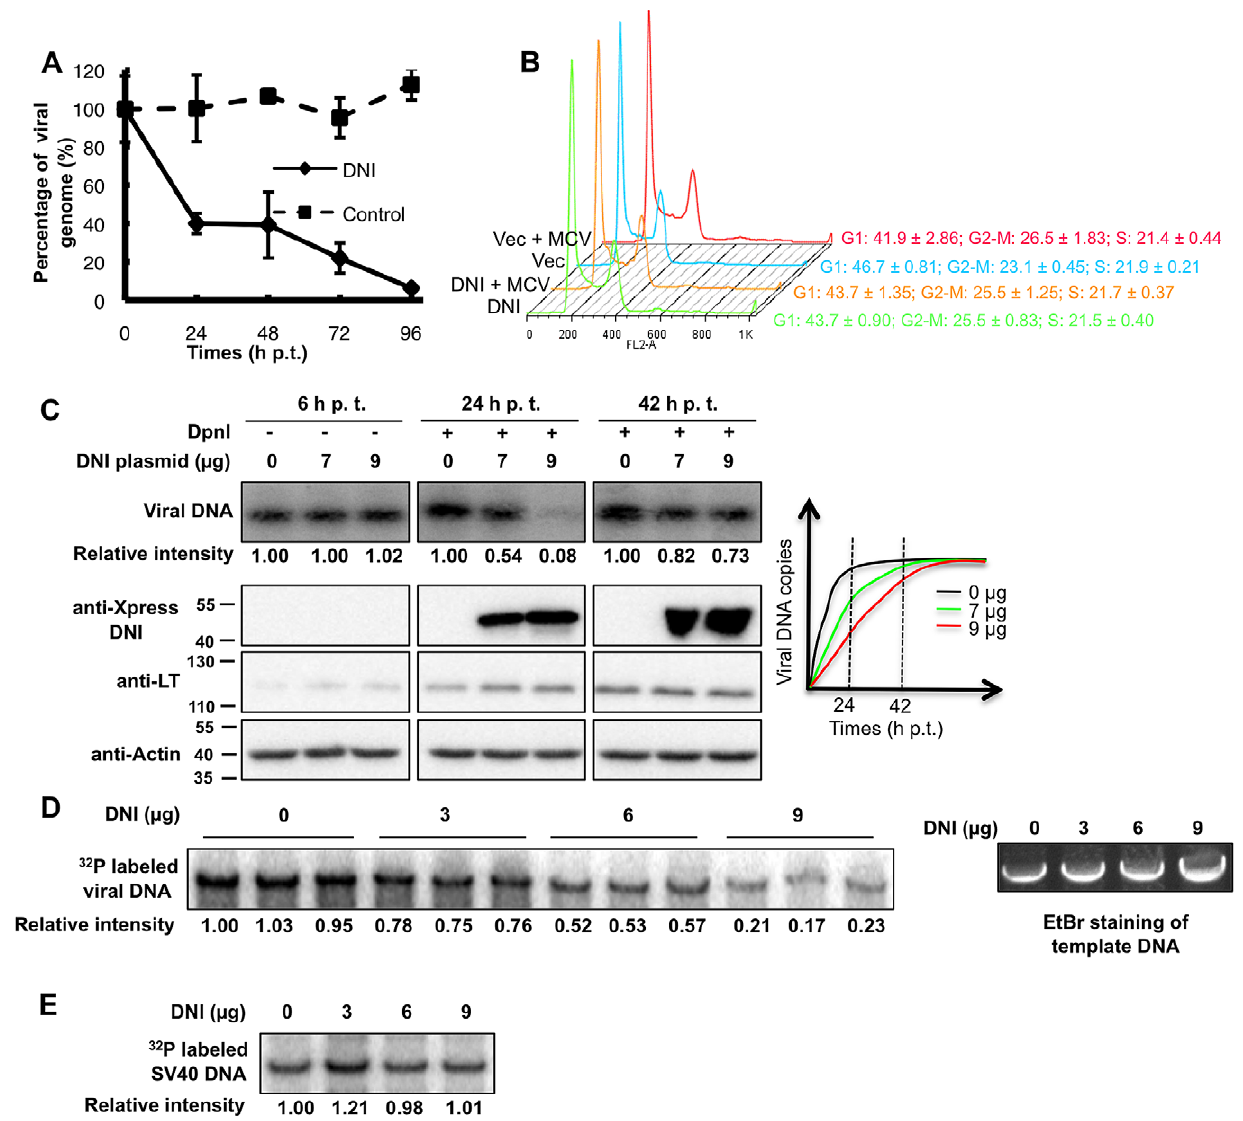
Figure 5. The DNI inhibits MCV DNA replication. A . DNI expression reduces MCV genome replication in an MCV sT/LT stable cell line. 293-4T cells were transfected with the MCV genome. At 84 h p.t., cells were re-transfected with either pcDNA4C-Brd4 471-730 (DNI) or pcDNA4C (control). The time for the second transfection was set as 0 hr. Viral genomes present in cellular DNA extracted at different time points were quantified using qPCR. Viral genome copies were normalized to beta-actin DNA and presented as a percentage of the viral genome detected at 0 hr. Mean and standard deviation were calculated from three independent experiments. B . FACS cell cycle analysis. 293T cells were transfected with pcDNA4C (Vec) or pcDNA4C-Brd4 471-730 (DNI) either alone or together with re-ligated MCV genome (MCV) as indicated. At 48 h p.t., cells were fixed and subjected to FACS analysis. C . The DNI inhibits autonomous MCV replication. 293T cells were co-transfected with 1 m g MCV genome and either 0, 7, or 9 m g of pcDNA4C-Brd4 471-730 (DNI). 2 m g of cellular DNA from 6 h p.t. was digested with EcoRI to show that equal amount of viral genomes were transfected into cells. 10 m g of DNA extracted from 24 and 42 h p.t. was digested with EcoRI and DpnI to detect the replicated viral DNA. The viral DNA was analyzed using Southern blotting. Intensities of autoradiography signal were analyzed using ImageJ and normalized to the value obtained with 0 m g of DNI at each time point. Protein extracts were immunoblotted for Xpress-DNI, MCV LT and actin. A schematic diagram of MCV replication time-course is also shown. D . The DNI inhibits viral DNA synthesis in vitro . 293T cells were co-transfected with pcDNA4C-MCV LT and pcDNA4C-Brd4. Cellular extracts were supplemented with increasing amount of recombinant DNI and used in the in vitro MCV replication assay. All reactions were performed in triplicates. DNA from the same reactions omitting [ a - 32 P] dCTP and creatine kinase were resolved on an agarose gel and stained with ethidium bromide. E . The DNI does not inhibit SV40 replication in vitro . In vitro replication using 293T cell extracts and pEGFP-C1 (carrying SV40 Ori) as template was performed as described in D . Increasing amount of recombinant DNI was added to the in vitro replication